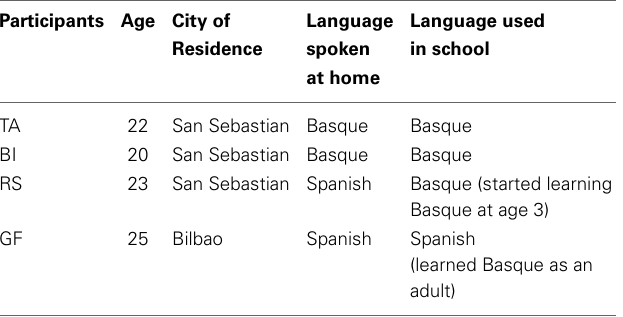
Table 1 | Adult participants’ information (Austin, 2006). Table 2 | Language background of bilingual child participants.